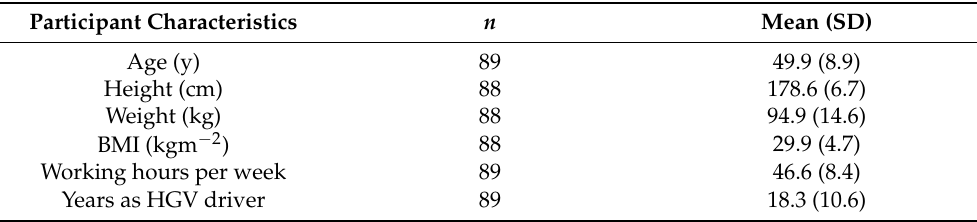
Table 1. Descriptive statistics of the study sample at baseline (98.9% male). BMI, body mass index; HGV, heavy goods vehicle.